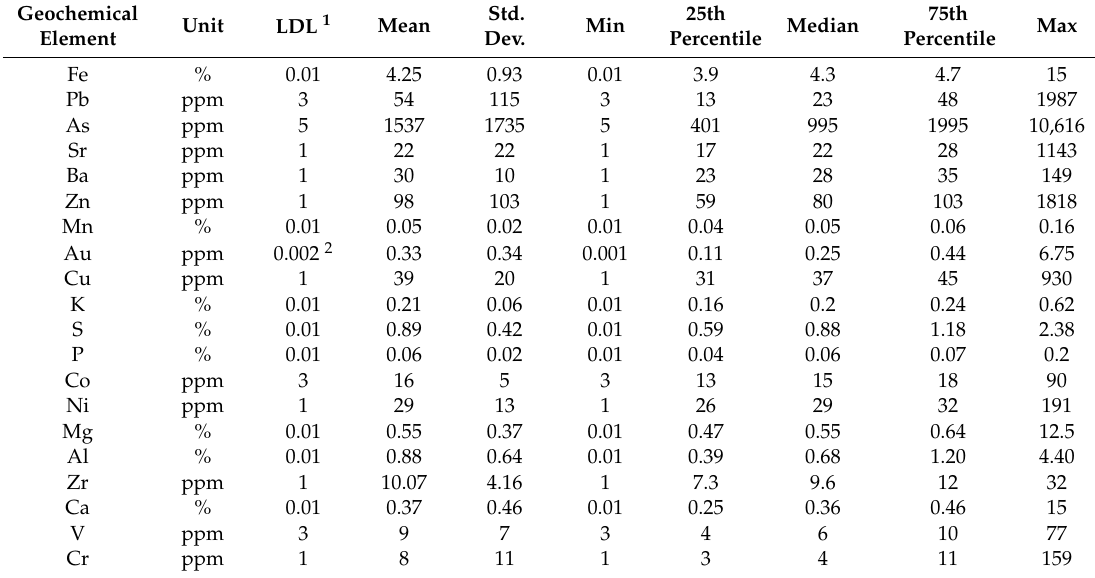
Table 2. Summary of 20-element subcomposition selected as geochemical variables for this study. Geochemical